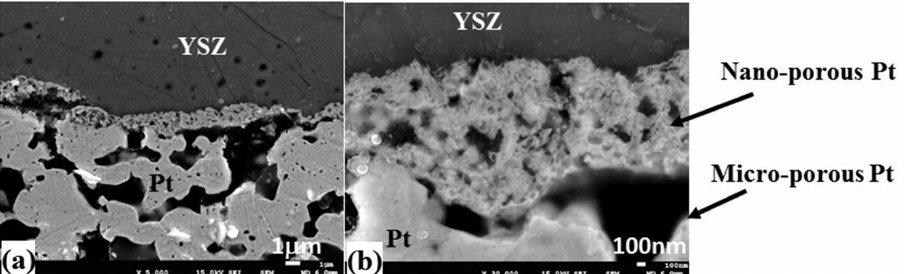
Figure 9: Interface between Pt cathode and YSZ after experi- ment (maximum potential: 2